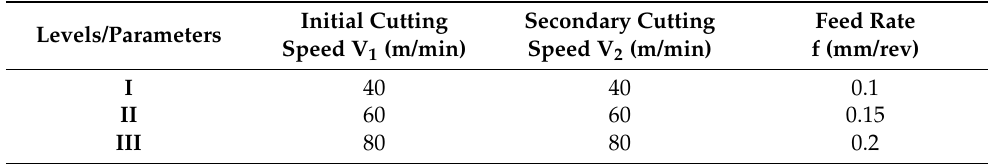
Table 3. Considered input cutting